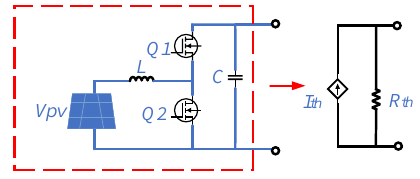
Figure 2. The equivalent circuit for PV